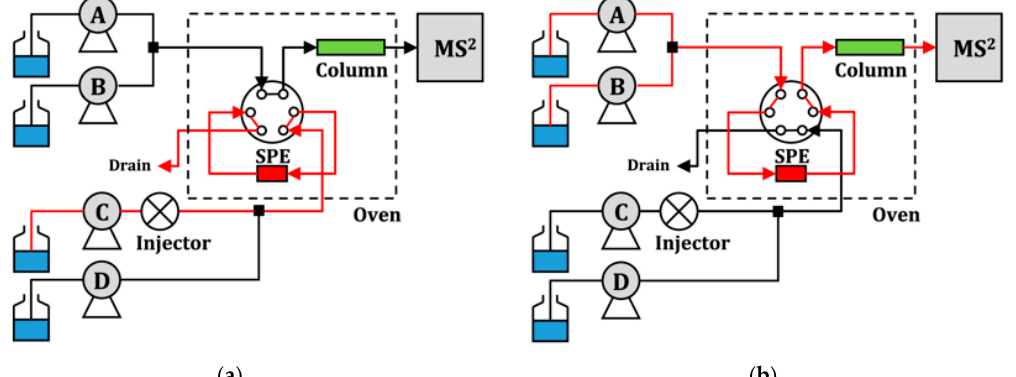
Figure 4. Configuration of the online SPE liquid chromatography tandem mass spectrometry (SPE-LC-MS/MS) system. I. separation column equilibration (pump A and B); II. sample loading and trapping (pump C); III. SPE desorption (pump A and B) and cleaning (pump D). Reproduced from [68] with permission from Elsevier. ( a ) Sample loading (Pump A, B, and C: On); ( b ) Sample analysis (Pump A, B, and D: On)